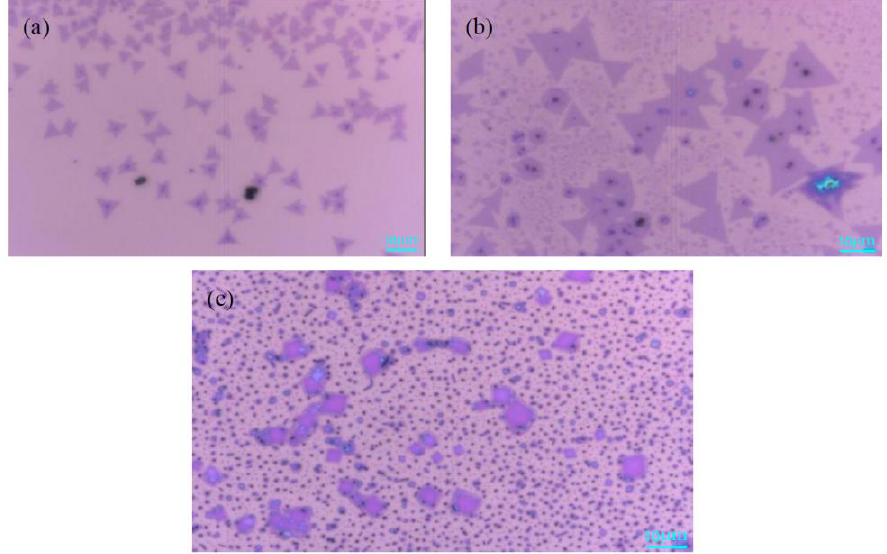
Figure 3. Optical microscope images of MoS 2 with the different MoO 3 mass ( a ) 1 mg; ( b ) 3 mg; ( c ) 5 mg. Scale bar: 10 μm .